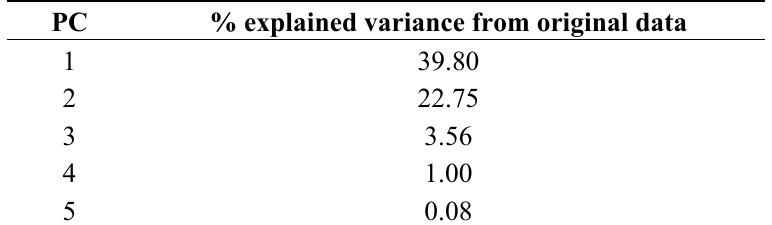
Table 5. Results of PCA analyses of anti- Cryptococcus